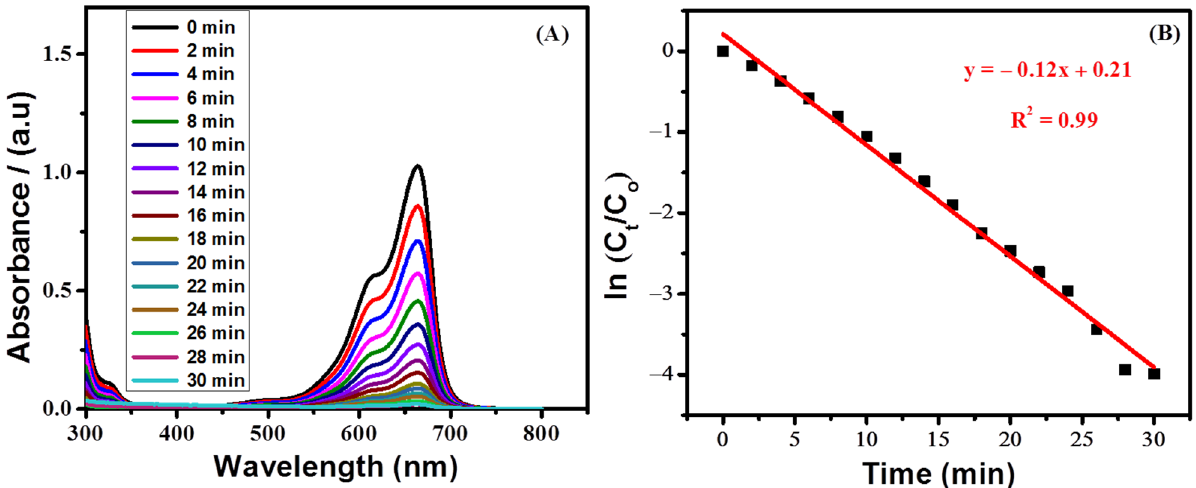
Figure 9. ( A ) UV-visible spectra showing photodegradation of 0.1 mM methylene blue in the presence of TiO 2 nanoparticles ( B ) Plot showing first-order kinetics of the photocatalytic degradation of methylene blue under basic conditions.